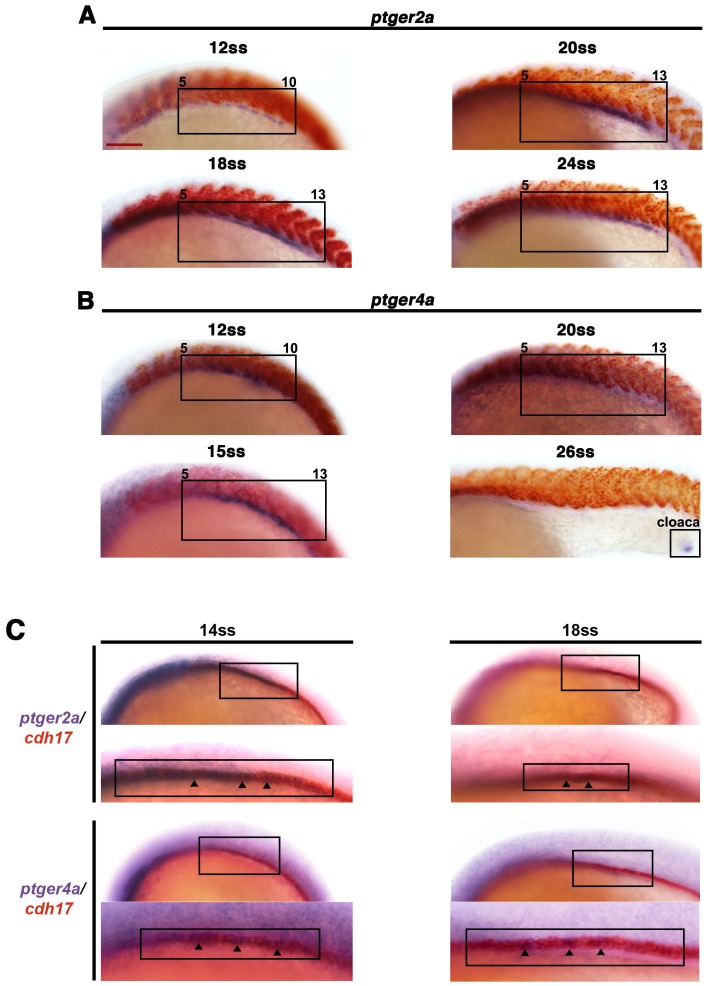
The prostaglandin receptor transcripts ptger2a and ptger4a are expressed in the pronephros during development and co-localize with the nephron.WT embryos from the 12 ss through 26 ss were stained for (A) ptger2a or (B) ptger4a transcript expression (purple) and the somites (red) using WISH. The ptger2a and ptger4a expression domains are framed in black boxes. WT embryos at the 14 ss and 18 ss were co-stained for (C) ptger2a and cdh17 (D) and ptger4a and cdh17, where transcripts encoding the latter mark the entire nephron. Asterisks demarcate co-localization between markers. Black bars indicate receptor gene expression domain. Red scale bar, 70 µm.